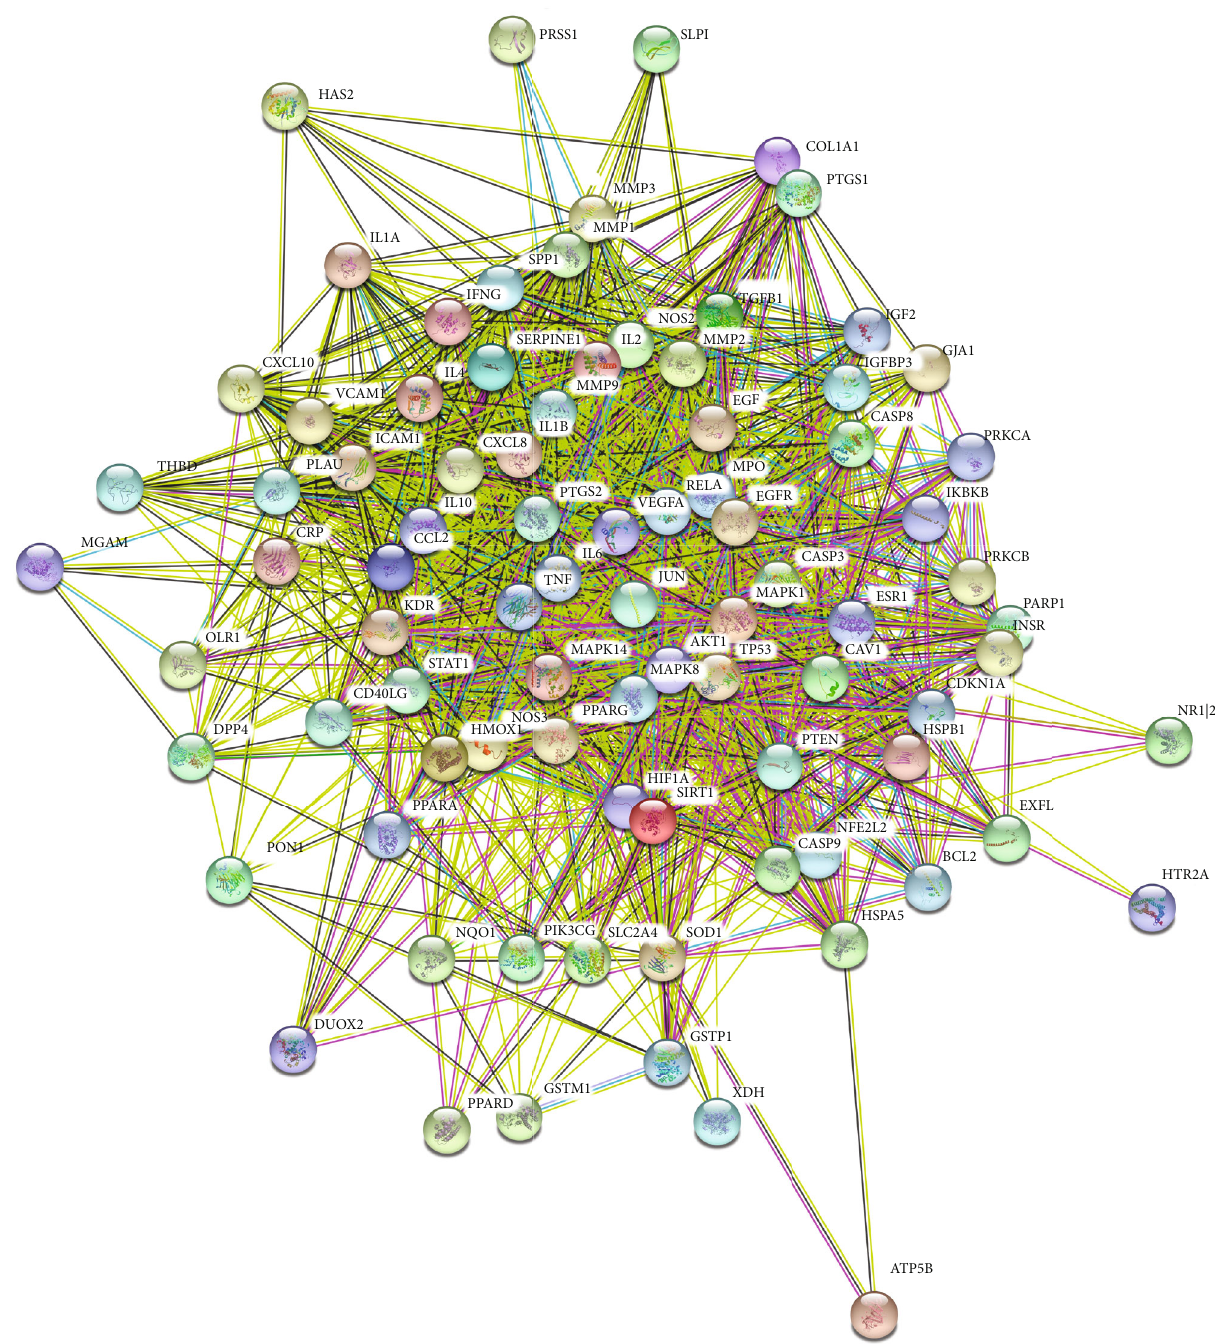
Figure 4: Common target gene association interactions network between TSF and DN from the STRING database. Each bubble node represents a target, and the 3D structure in the bubble nodes represent that the protein spatial structure is known or predicted. The lines among inner nodes display the relationship between di ff erent targets, and the width of lines was based on the strength of data